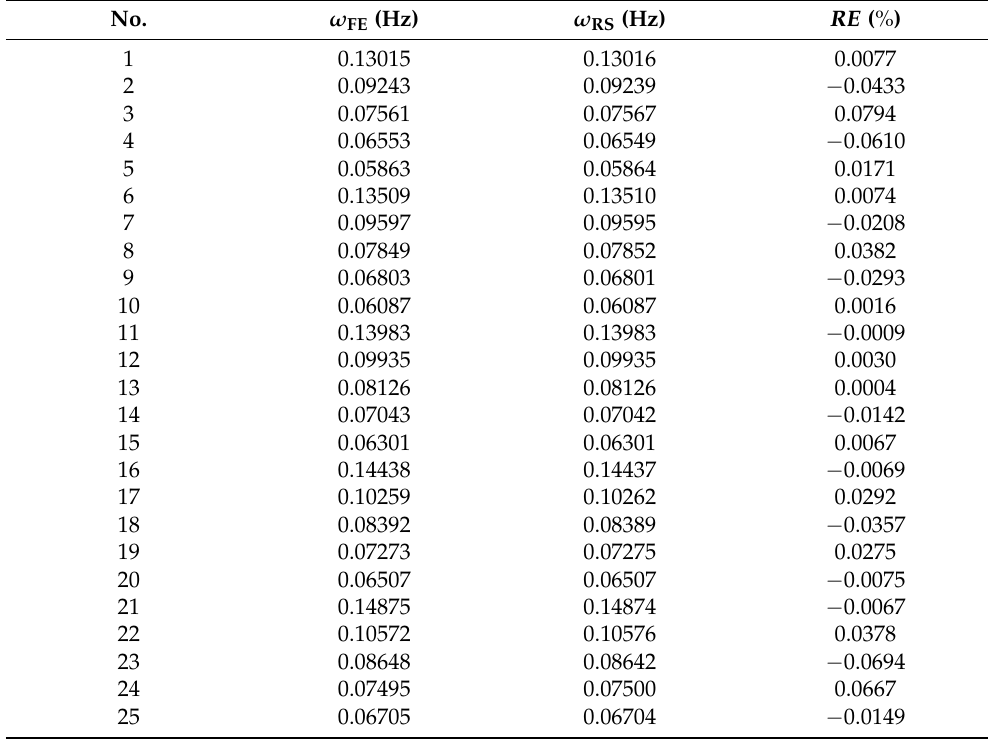
Table 5. Comparison between ω FE and ω RS .